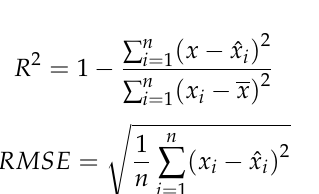
Table 1. Parameters related to GPR